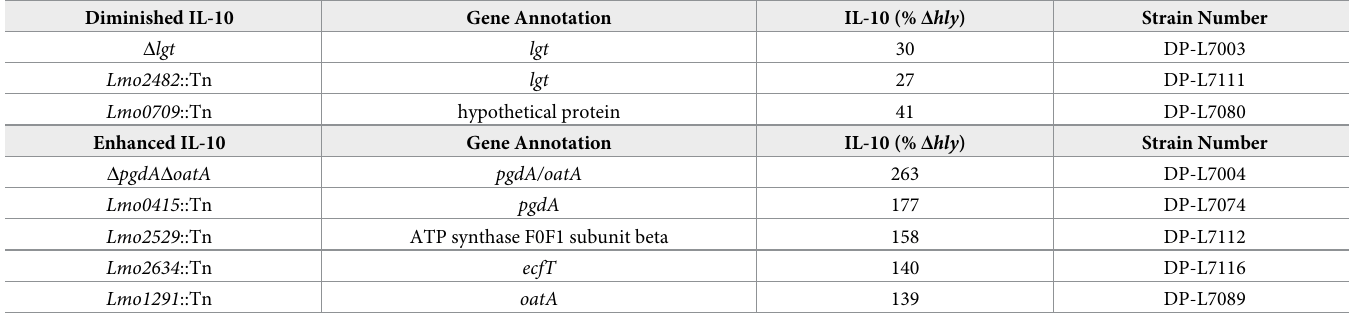
Table 1. IL-10 secretion four hours post-infection of BMMs with deletion mutants and transposon mutants identified in genetic screen. Diminished